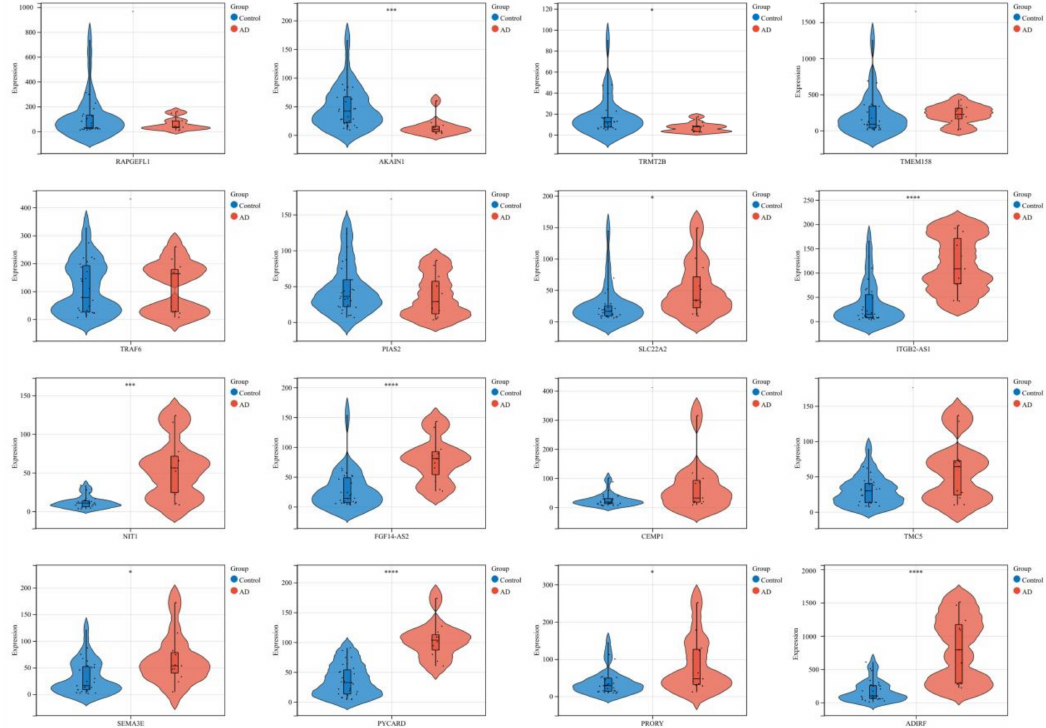
Figure 4. Verification of the DEGs through violin plot. *: p < 0.05 ( TRMT2B , SLC22A2 , SEMA3E